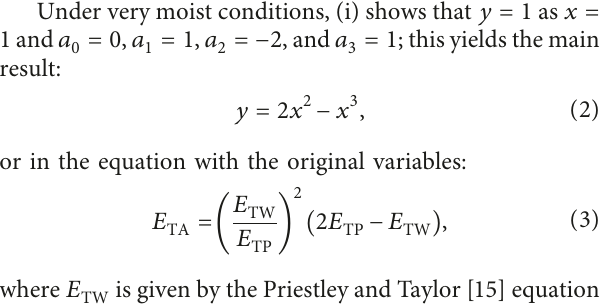
represents the TP represents the wet TW